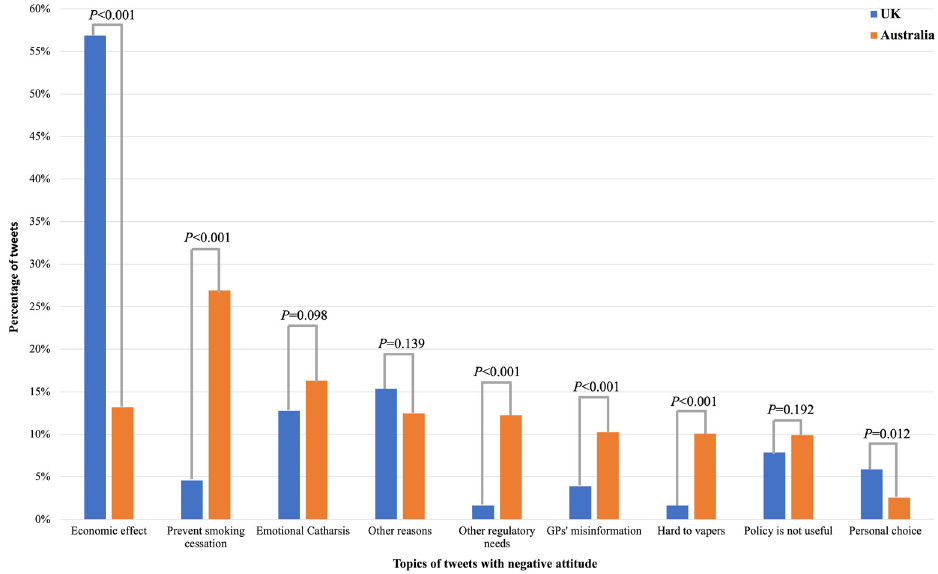
Figure 4. Topics in tweets with negative attitudes towards the e-cigarette prescription policy in the UK and Australia.